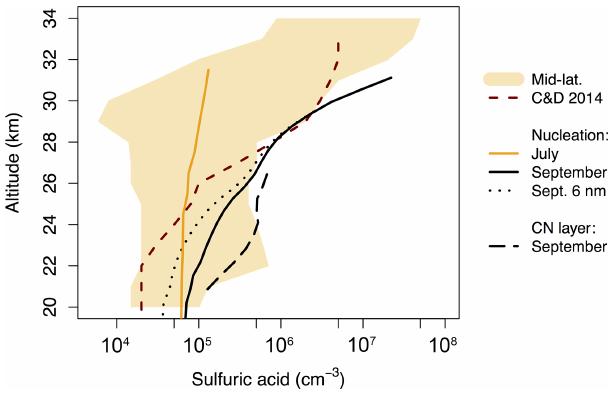
Figure 7. Comparison of our derived Antarctic sulfuric acid pro- files (nucleation threshold: solid; CN layer: long dashed) with the derived profile from Campbell and Deshler (2014) (dark red, short dashed) and midlatitude measurements and modeling of Arnold et al. (1981), Reiner and Arnold (1997), Schlager and Arnold (1987), Viggiano and Arnold (1981), and Mills et al. (2005) (shaded area). The September nucleation threshold profile for nucleation and growth to a lower cutoff of 6nm from Fig. 6a is also included (black